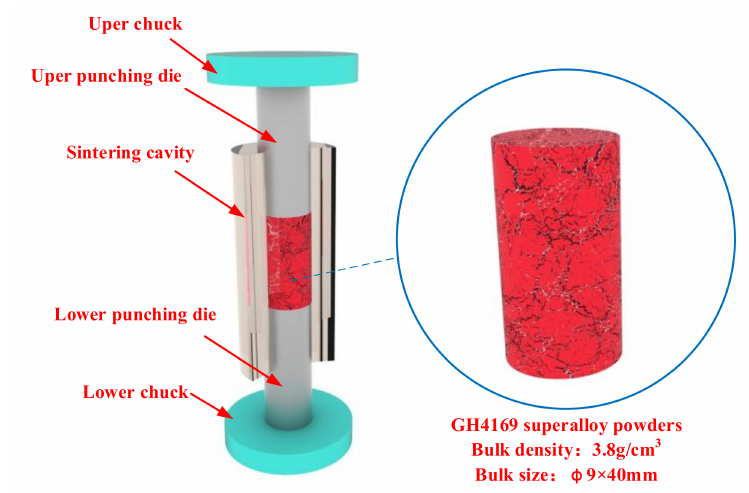
Figure 1. Die structure and the Inconel 718